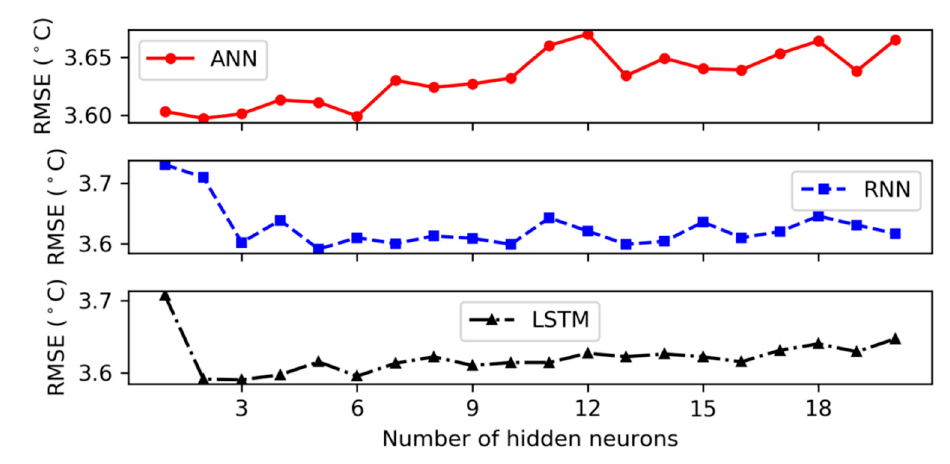
Figure 6. Root mean square error corresponding to different number of hidden neurons for 1 hidden layer in spring.